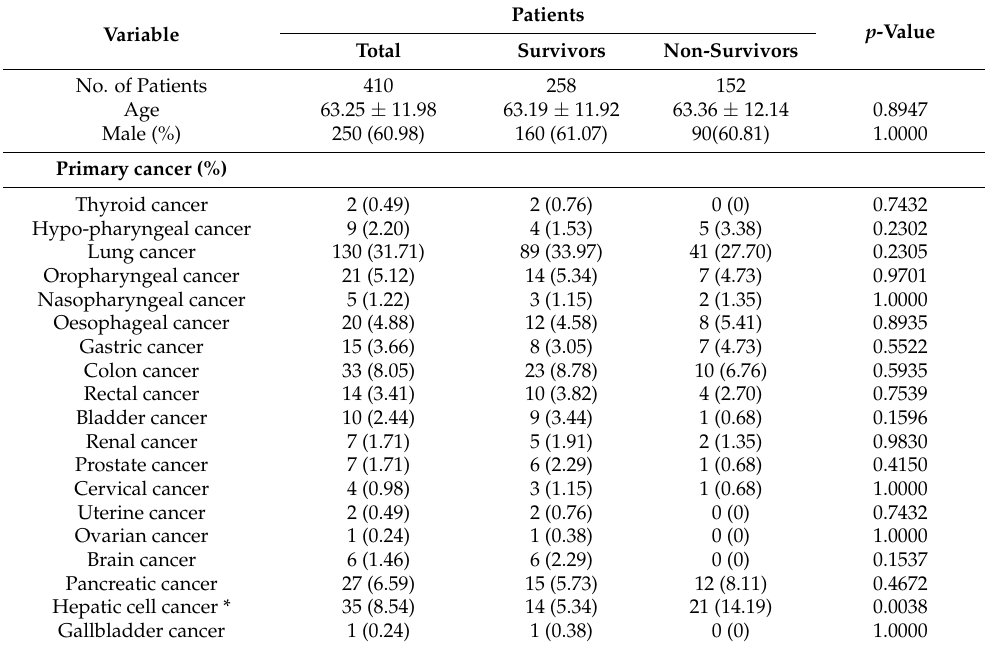
Table 1. Comparison of the medical history of patients, survivors versus non-survivors at 60 days after the index emergency department